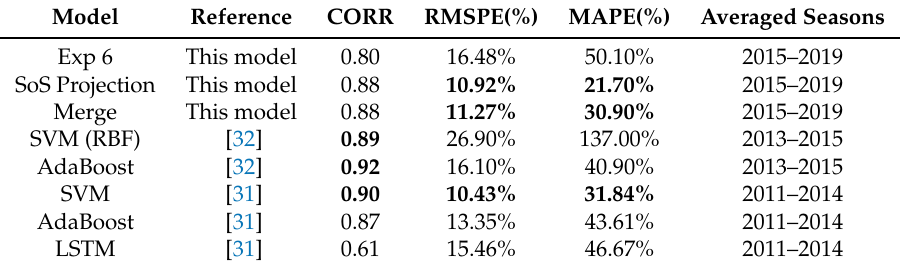
Table 6. Comparing the merge prediction with other methods. Metrics are calculated averaging consecutive testing